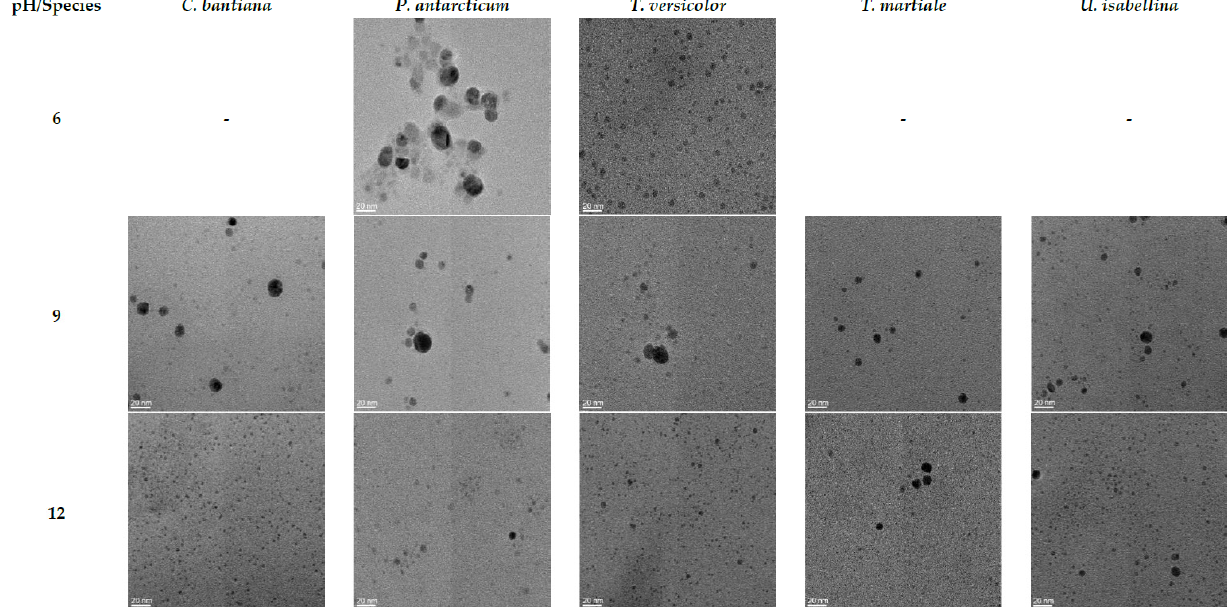
Figure 8. TEM (20 nm scale) characterisation of the biological AgNPs. AgNPs were synthesised by adding 0.5 mM AgNO 3 , with 1 h reaction time, at a temperature of 90 °C, varying the pH. Images of the AgNPs synthesised at pH 6 are shown in the second row, pH 9 in the third row and pH 12 in the last row. AgNPs synthesised using the fungal cell-free extracts of C. bantiana are shown in the second column, P. antarcticum in the third column, T. versicolor in the fourth column, T. martiale in the fifth column and U. isabellina in the last column.